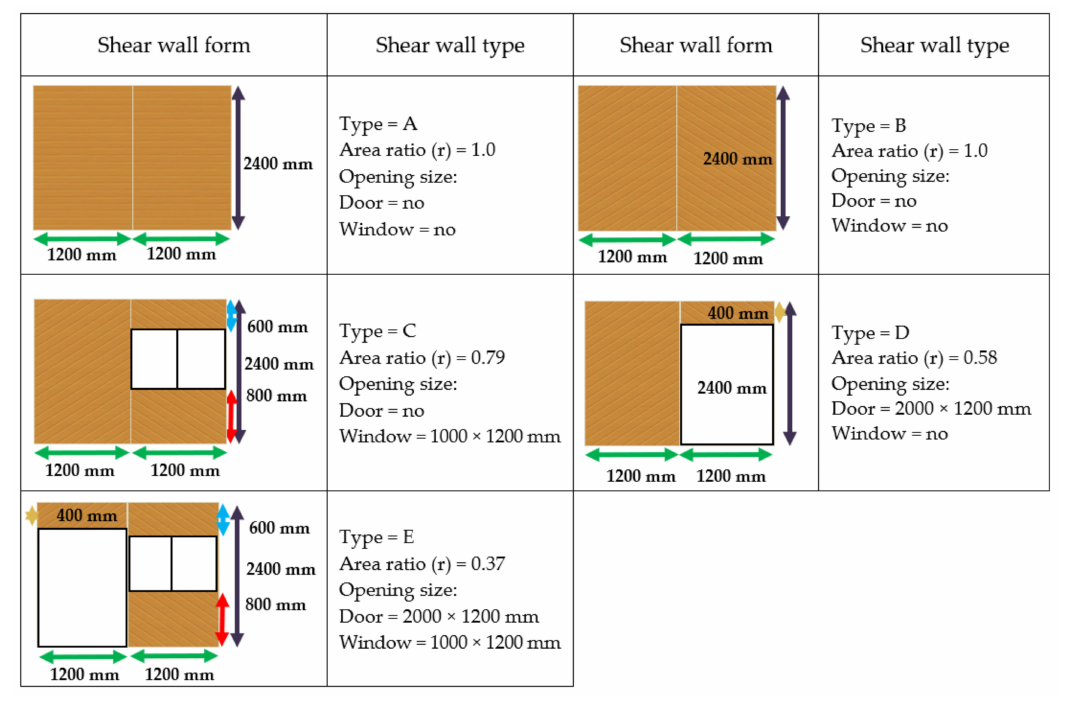
Figure 5. Schematic drawing of shear wall components.